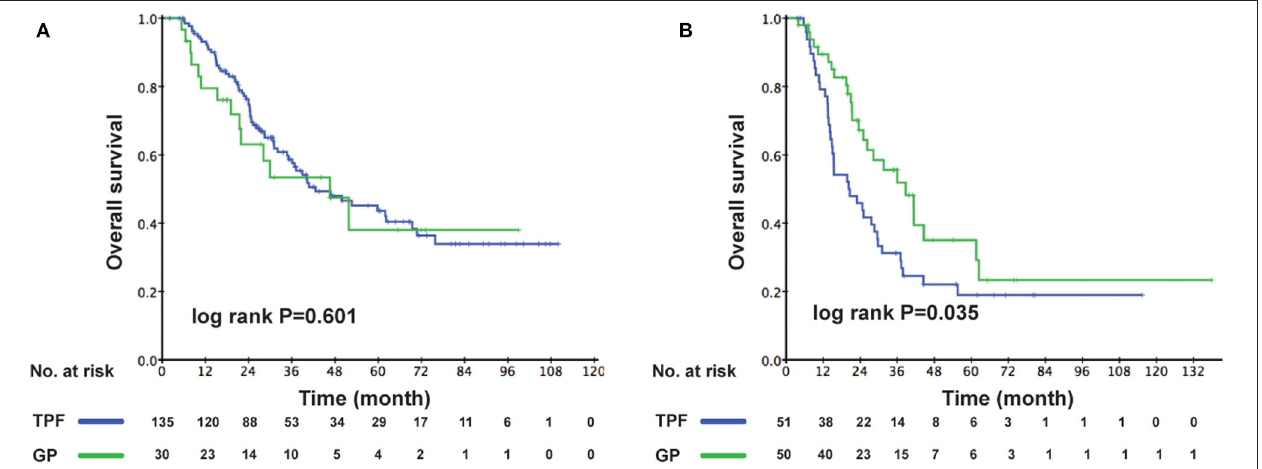
FIGURE 5 | Comparison of OS for patients in the GP and TPF groups: (A) patients with primary metastases and (B) patients with secondary metastases. OS, overall survival; GP, gemcitabine plus cisplatin; TPF, docetaxel plus fluorouracil plus cisplatin.